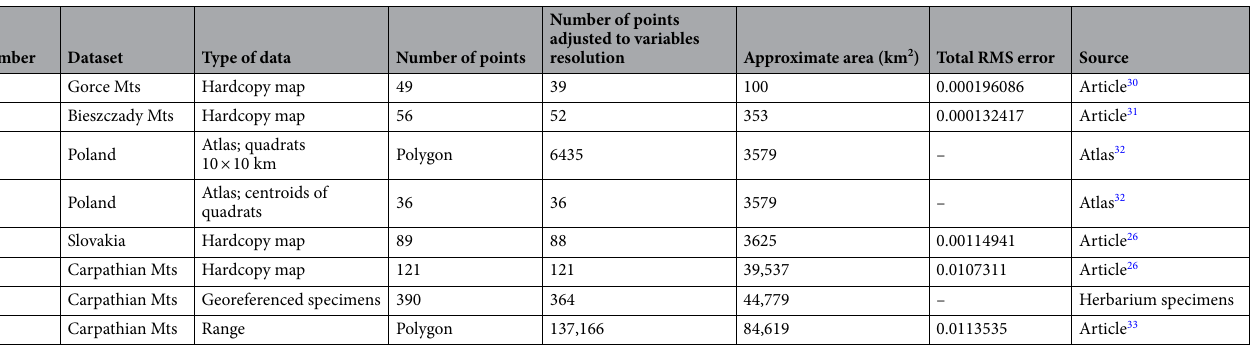
Table 1. Details of datasets used in this study showing name, type of data, number of points appearing in source and number adjusted to resolution of variables, approximate area covered by points, RMS error, and source of data. In the case of datasets 3a and 3b, we tested two versions: the original 10 × 10 km quadrats (each containing around 100 points) and the centroids of those quadrats. Datasets 1 to 5 represent scanned and georeferenced hardcopy maps, dataset 6 represents georeferenced specimens, and dataset 7 represents a species range drawn as a